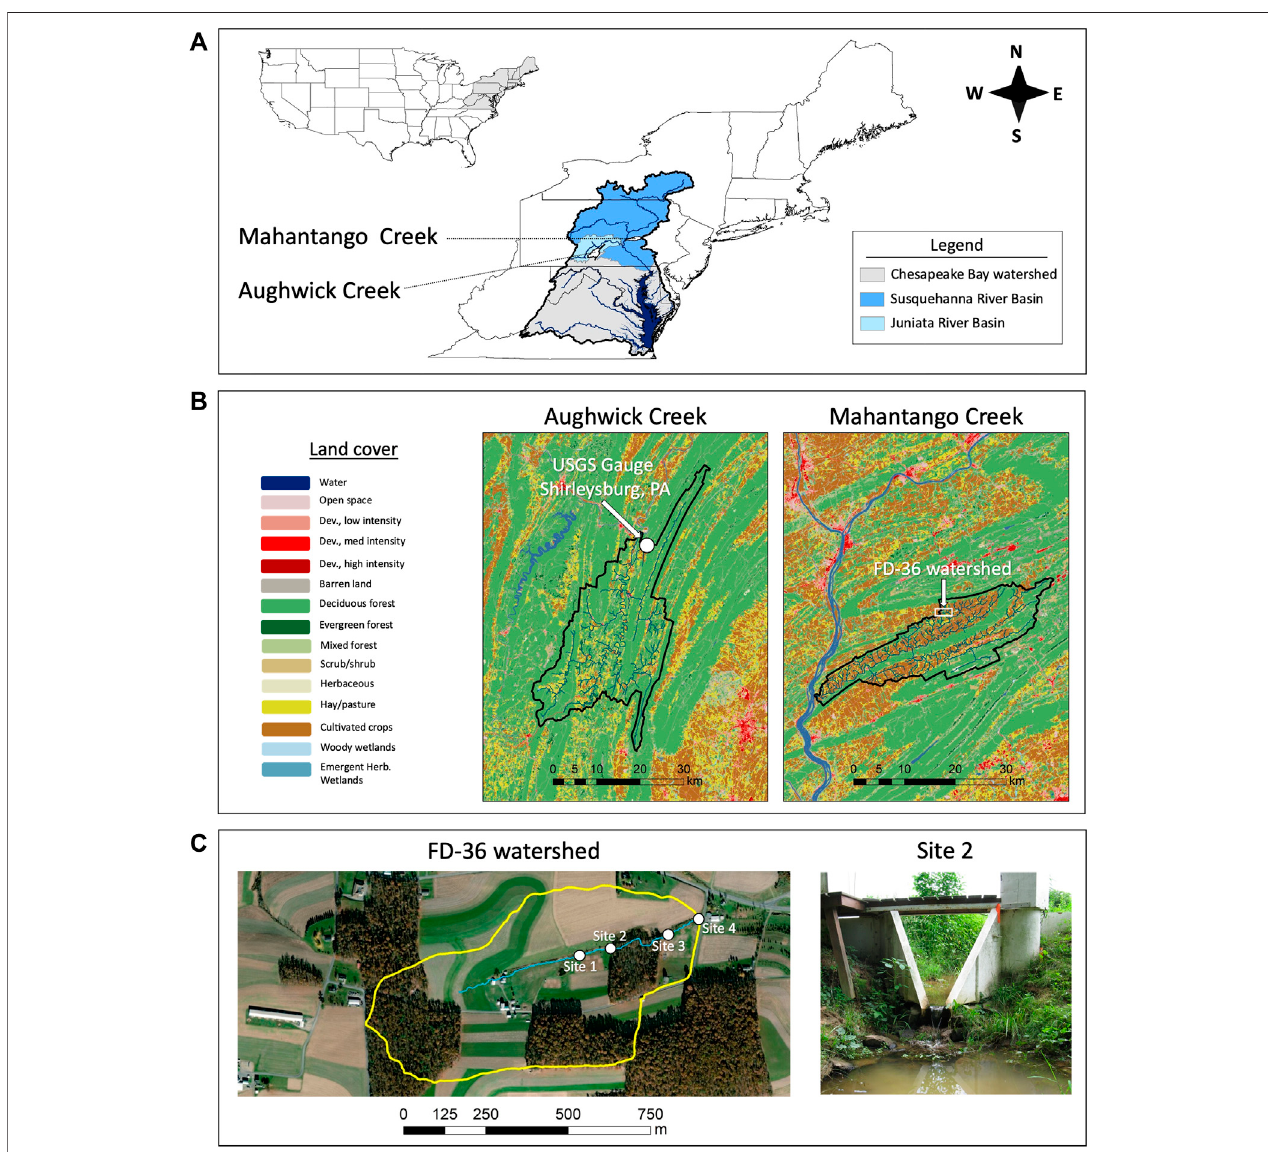
FIGURE1| Three-panel fi gureshowingthetwostudywatershedsand fi vesamplinglocations.Panel (A) depictsthelocationsofAughwickCreekandMahantango CreekwithintheChesapeakeBay watershed;Aughwick Creek isatributary totheJuniataRiver,while Mahantango Creek isatributary totheSusquehanna River. Panel (B) shows the land use distributions within Aughwick Creek and Mahantango Creek based on data from the 2016 National Land Cover Database (Homer et al., 2020). Also shown in Panel (B) is the location of the USGS stream gauge on Aughwick Creek near Shirleysburg, PA, which was one of the fi ve study sites. Panel (C) provides a close-up view of the four sampling sites within the FD-36 watershed (0.4-km2 tributary of Mahantango Creek), as well as a close-up photo of one of the sites (Site two).